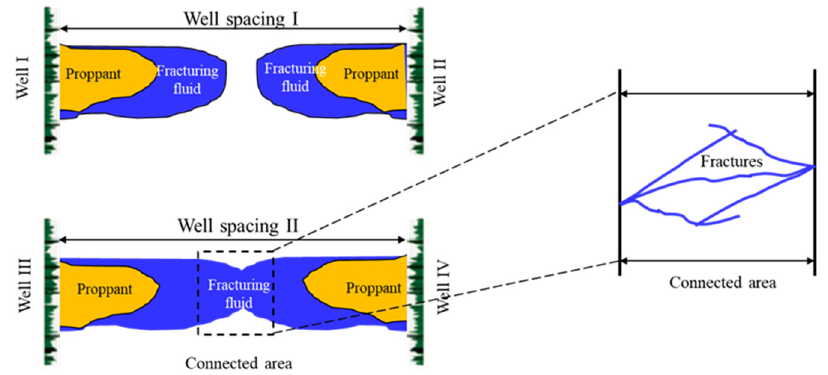
Figure 1. Schematic diagram of interwell interference and connected areas (Modified from [31]).